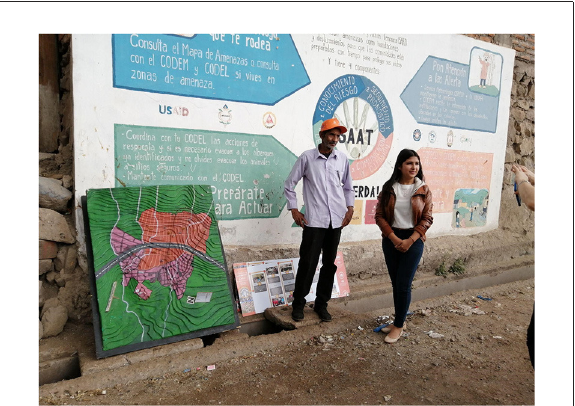
FIGURE6 Community youth painted a mural illustrating the four key components of the EWRS—Know the risk that surrounds you. Pay attention to alerts. Get informed and communicate. Get ready to act.—along with a three-dimensional hazard map of the neighborhood. Credit: GOAL,